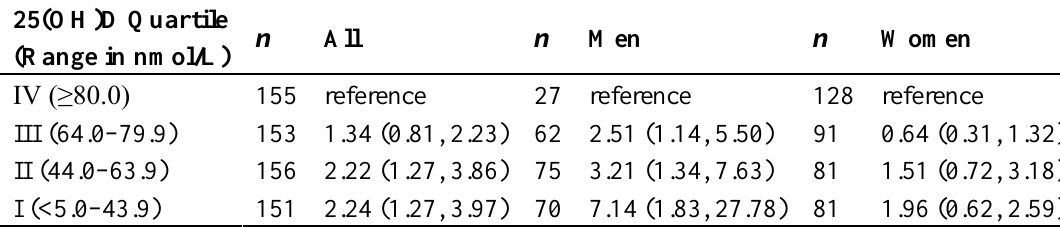
Table 3. Adjusted odds ratios (95% confidence intervals) for the presence of depressive symptoms (CES-D ≥ 16) and 25-hydroxyvitamin D